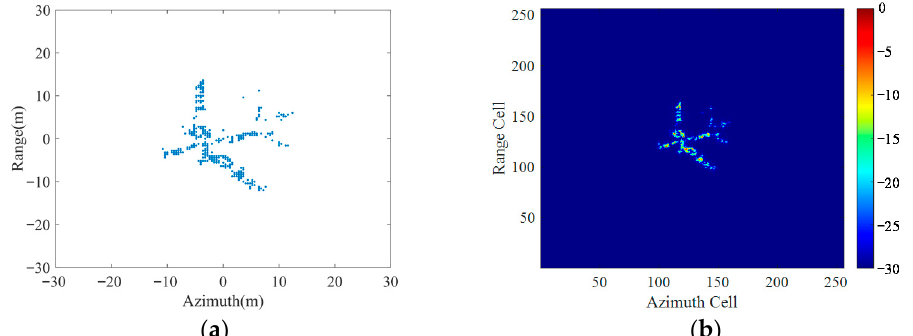
Figure 16. A block target sample from test set: ( a ) The coordinate distribution of the scattering points; ( b ) The ideal ISAR image.